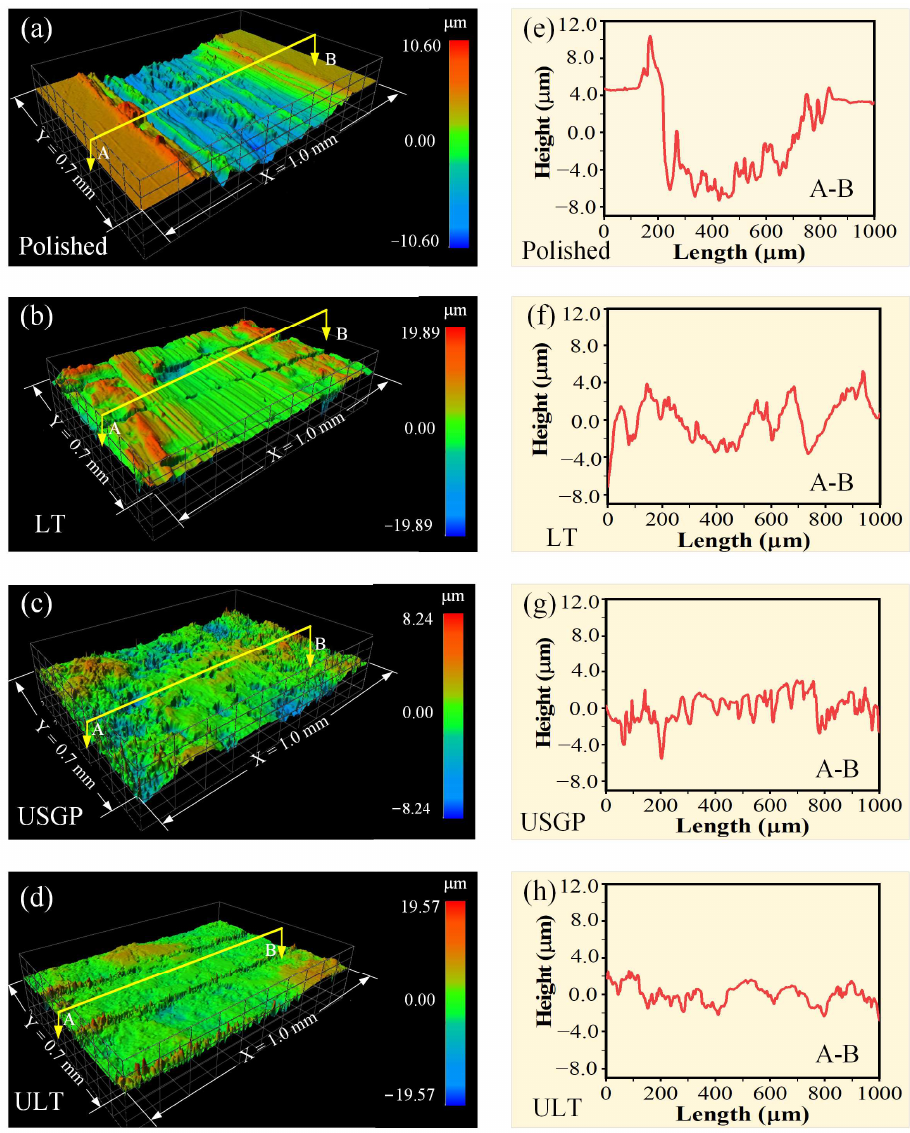
Figure 10. The micromorphology and cross-sectional profiles that took in the middle of the wear tracks of the polished ( a , e ), LT ( b , f ), USGP ( c , g ), and ULT samples ( d , h ).